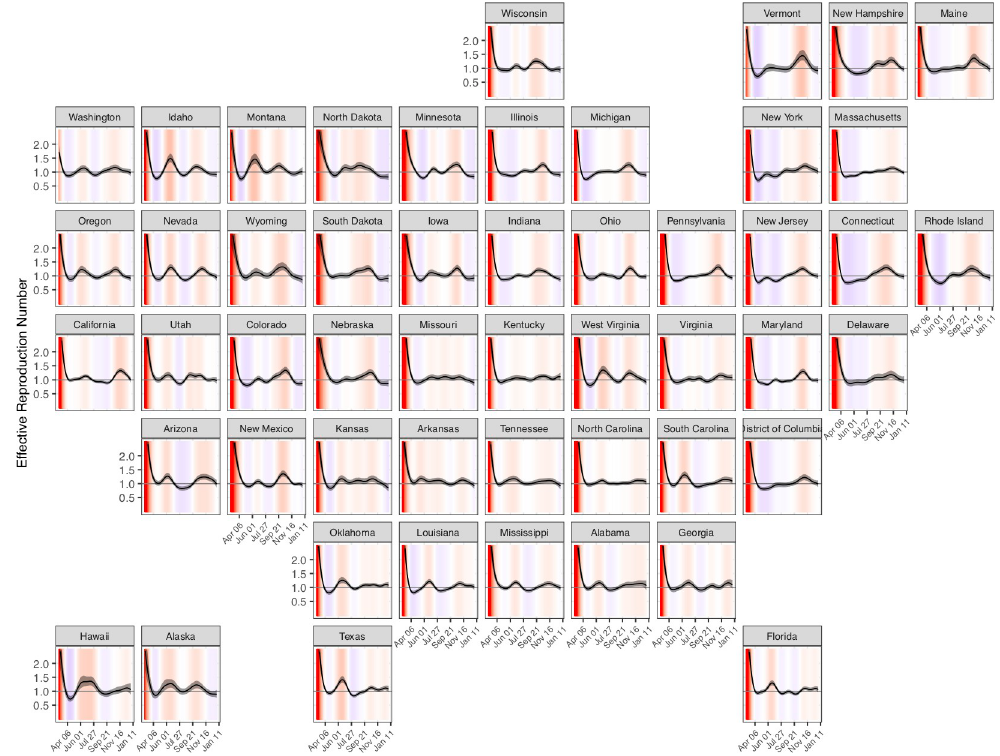
Fig 4. R t estimates for each US state from March 1, 2020 to January 1, 2021. Background colors indicate whether R t is substantially greater than 1 (red), close to 1 (white), or substantially less than 1 (blue). Grey line indicates R areas represent 95% credible